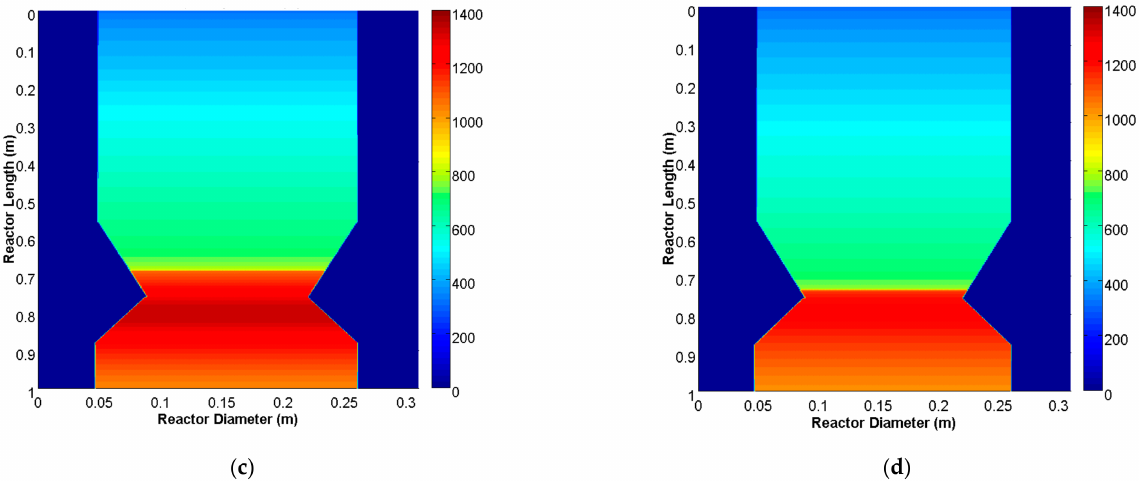
Figure 4. Numerical temperature profile (expressed in Kelvin) along the reactor axis for the four biomasses tested: